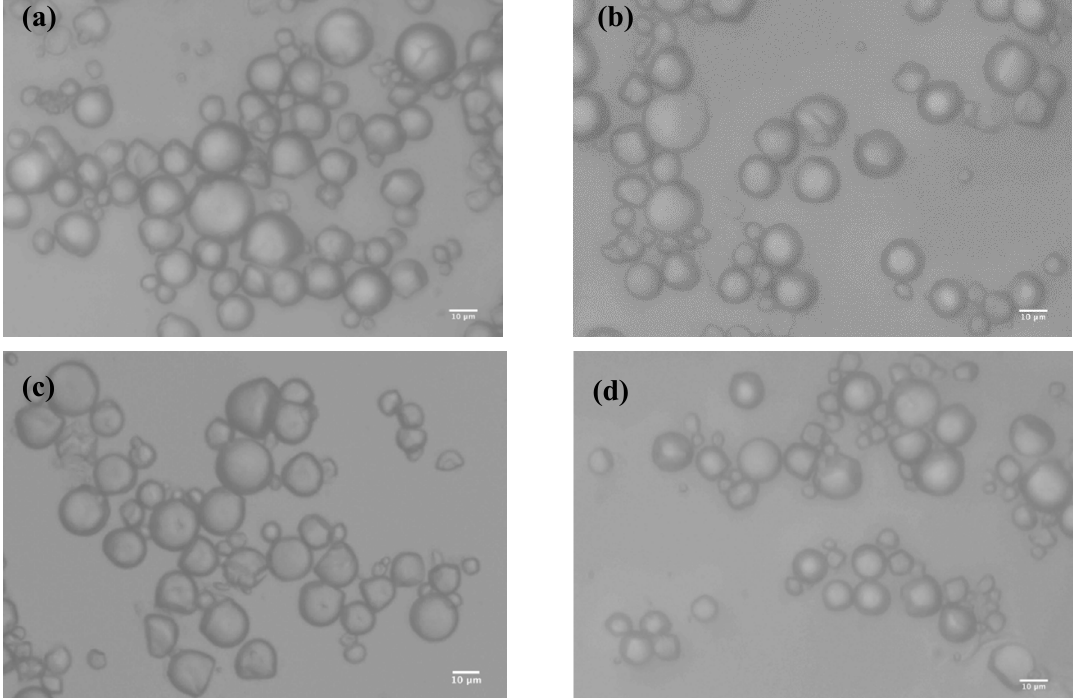
Figure 4. Granular cassava starch observations after pretreatments: ( a ) 30 °C; ( b ) 50 °C; ( c ) Viscozyme L and ( d ) Microwave.